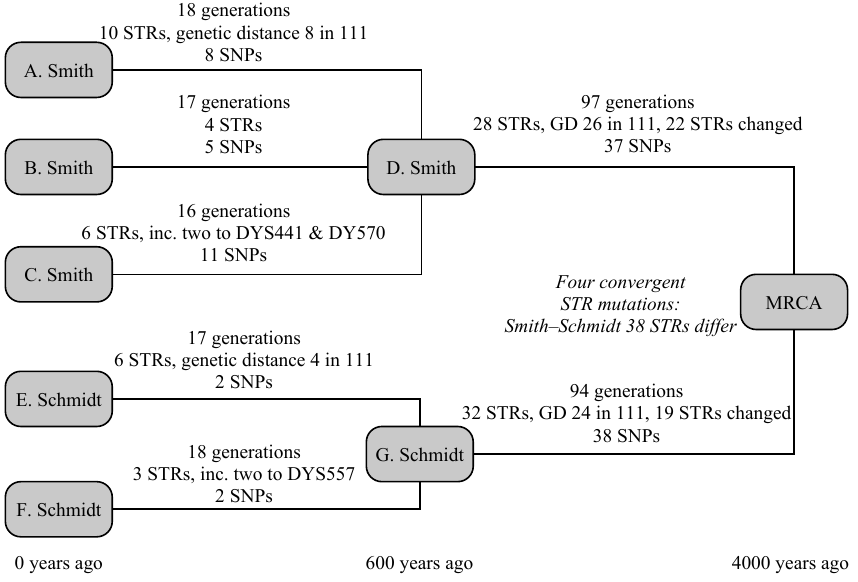
Figure 3. A schematic representation of the example given in Section 3.3.